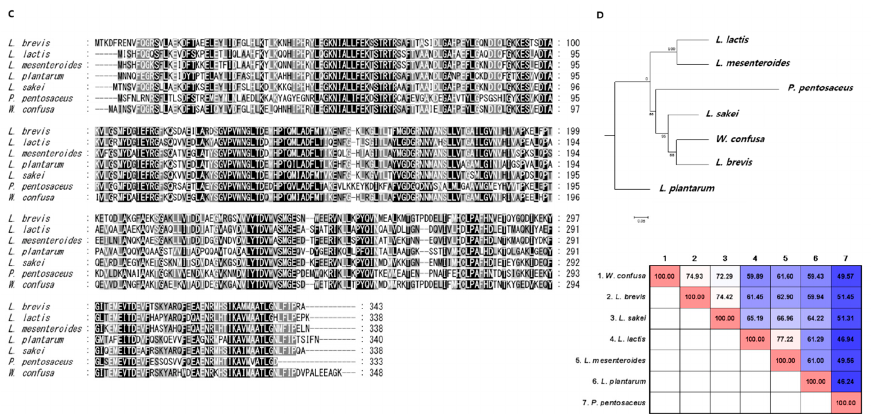
Figure 2. Comparison of ADI and OTC sequences between different lactic acid bacteria: ( A ) alignments of ADI amino acid (aa) sequences; ( B ) phylogenic tree of ADI; ( C ) alignments of OTC aa sequences; ( D ) phylogenic tree of OTC. The homology of each sequence is represented in a heatmap. Detailed information for the protein sequences (including accession numbers) is provided in Table 1.